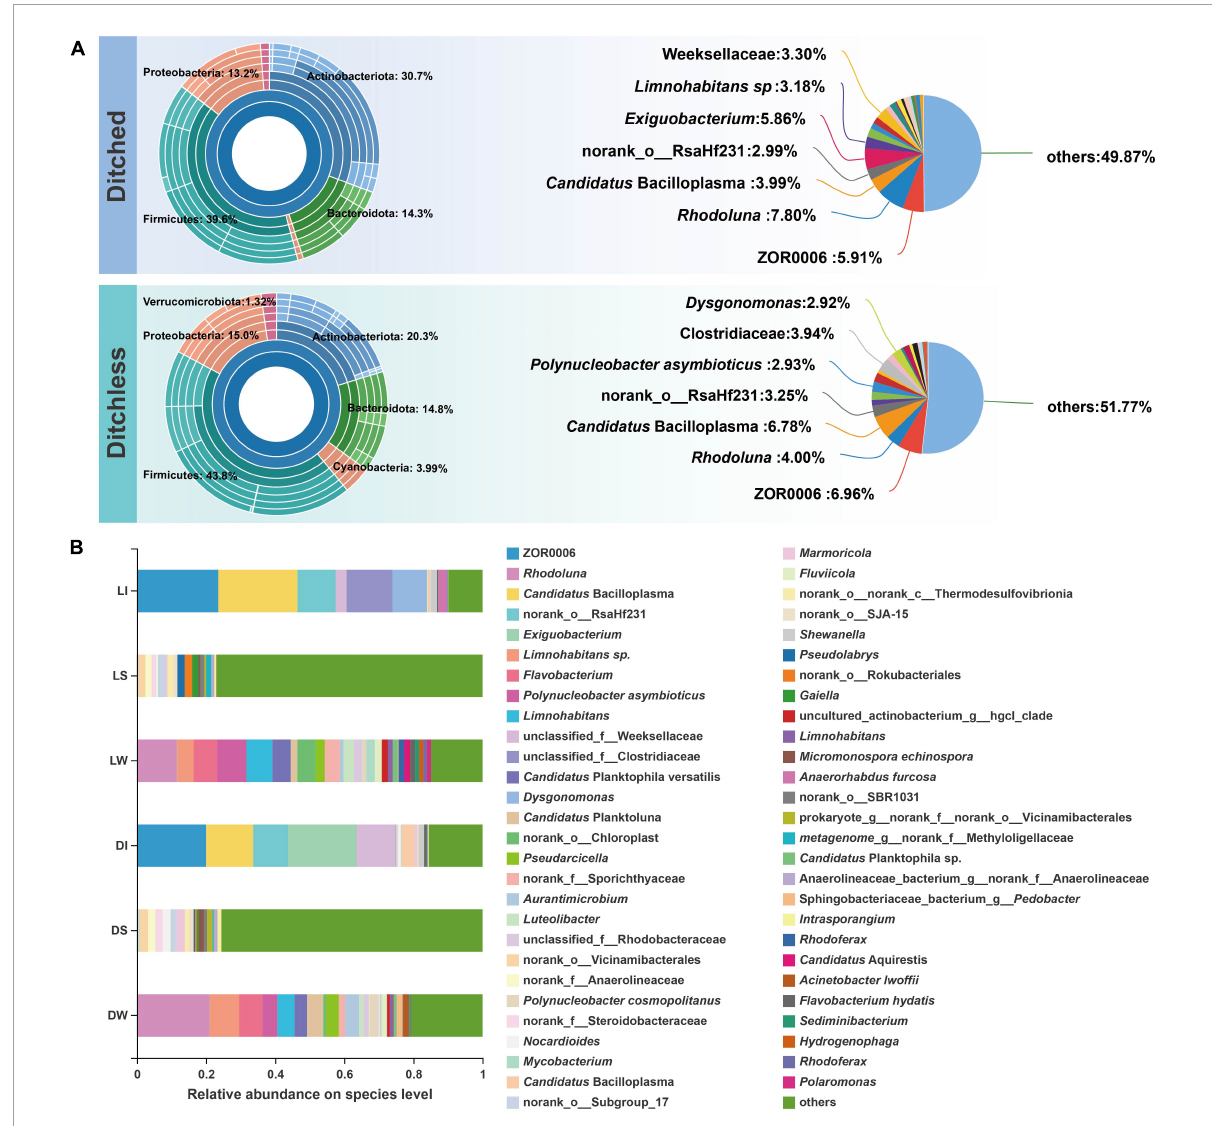
FIGURE2 Bacterial community structures of ditched and ditchless systems. (A) Sunburst plots and pie charts of the most abundant phyla. The samples of the ditched system include DI, DW, and DS. The samples of the ditchless system include LI, LW, and LS. (B) Species composition of each sample compiled from three